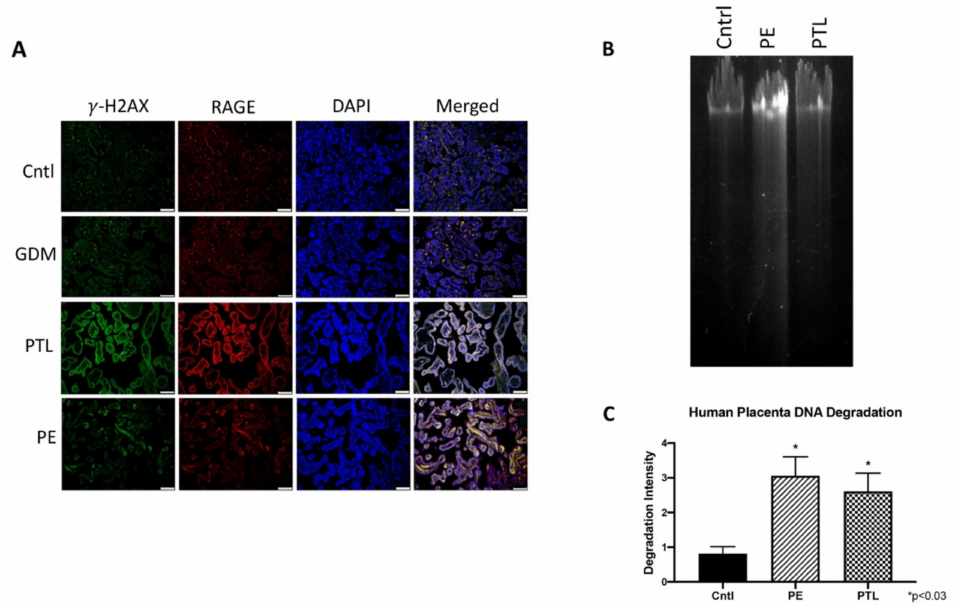
Figure 1. Genomic instability in pregnancy complications. ( A ) Increased staining and co-localization of DNA-DSBs ( Green , γ -H2AX), and RAGE ( Red ) was observed during PE and PTL conditions. DAPI ( Blue ) was used for nuclear staining. ( B ) Gel electrophoresis tail length revealed the degree of DNA damage. From left to right: Cntl, PE, and PTL). ( C ) Quantifications of the fragmented DNA tail length from DNA electrophoresis ( n = 6). Images (20 × magnification) are representative of experiments involving at least 6 placental sections from each